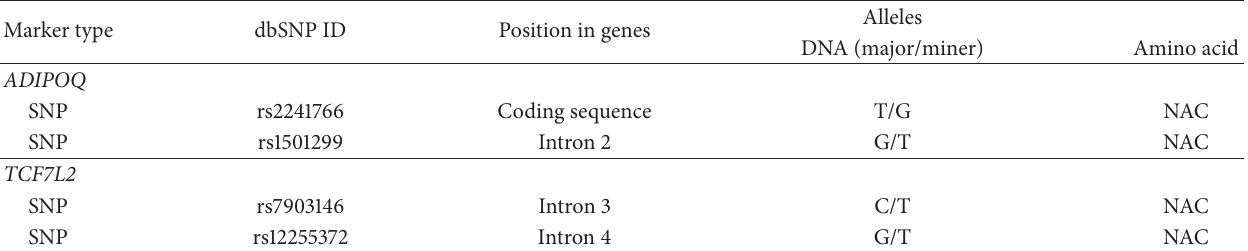
Table 3: Polymorphisms genotyped in this study.